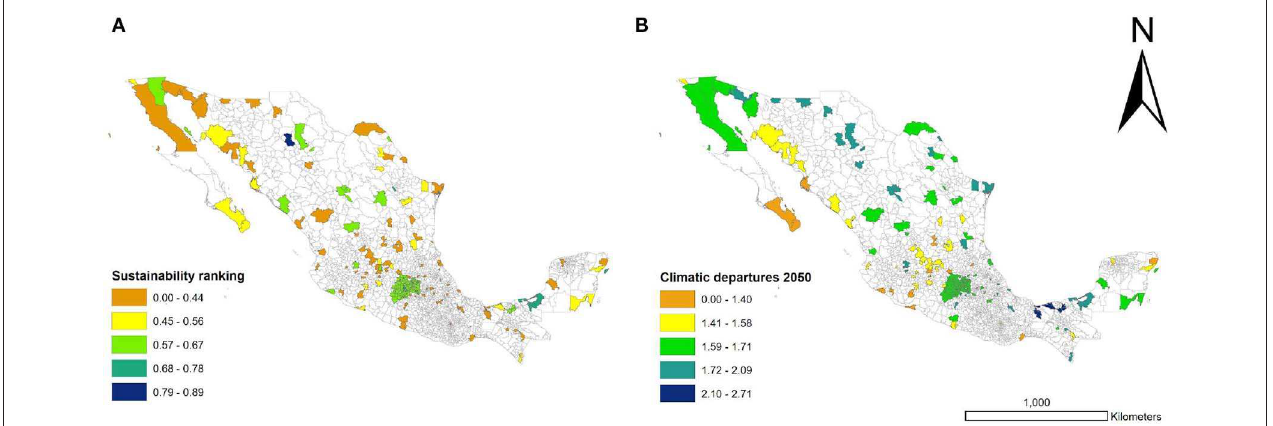
FIGURE 5 | Geographical distribution of sustainability ranking values (A) and climatic departures using Euclidean distances averaged for all climate change scenarios (GCM and RCPs) for 2050 (B) .